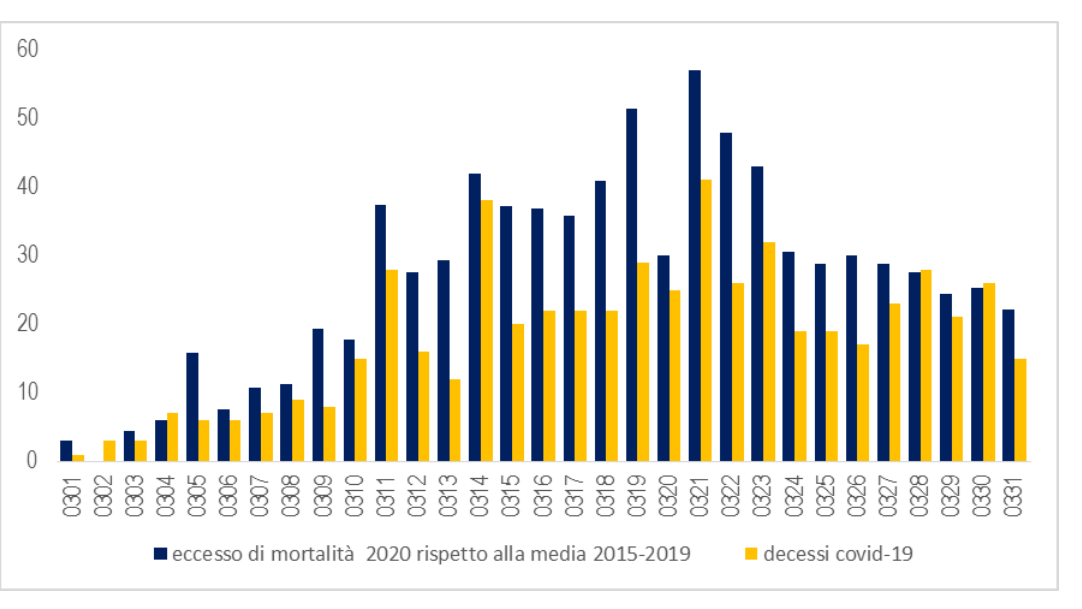
Figura 11. Andamento giornaliero nel mese di marzo dell'eccesso di mortalità registrato nel 2020 rispetto alla media degli anni 2015-2019 e dei decessi Covid- 19 (a) . Valori assoluti dei decessi di persone in età 50 anni e più. Provincia di